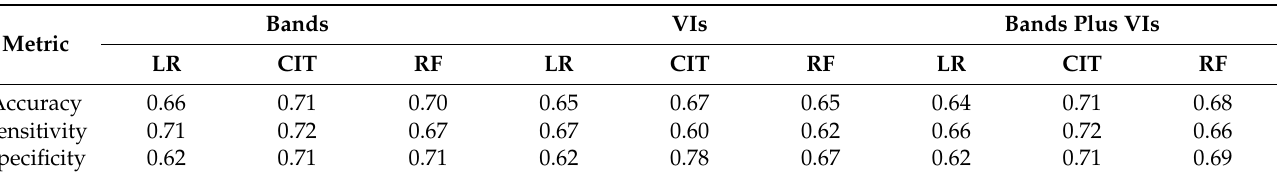
Figure 3. Spectral reflectance curves from asymptomatic (green) and symptomatic (yellow) soybean plants with ( A ) all replications ( n = 115) from all three sites, and ( B ) summarized reflectance as boxplots obtained for each condition. On panel ( B ), boxplots portray the 25th (lower hinge), 50th (solid black line), and 75th (upper hinge) percentiles, largest value no further than 1.5 × inter-quartile range (lower whisker), smallest value at most 1.5 × inter-quartile range (upper whisker), and outlying observations (points). * Represent significant differences between conditions within a given band at α = 0.05. Table 4. Accuracy, sensitivity, and specificity from the classification of soybean condition (symp- tomatic vs. asymptomatic) from three algorithms (logistic regression—LR, random forest—RF, and conditional inference tree—CIT) and three data input (bands only, vegetation indices—VIs-only, bands plus